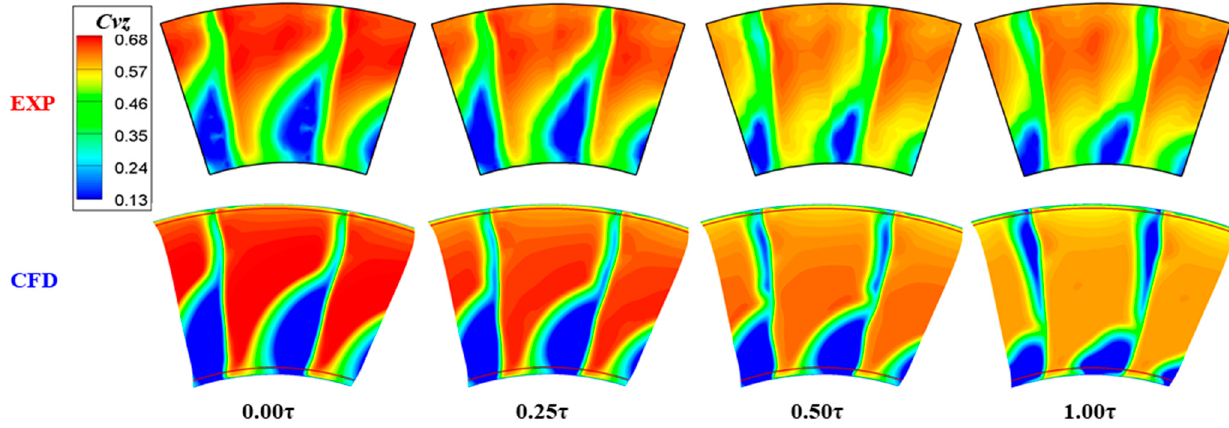
Figure 8. Distribution of the normalized axial velocity of the stator outlet in the NS